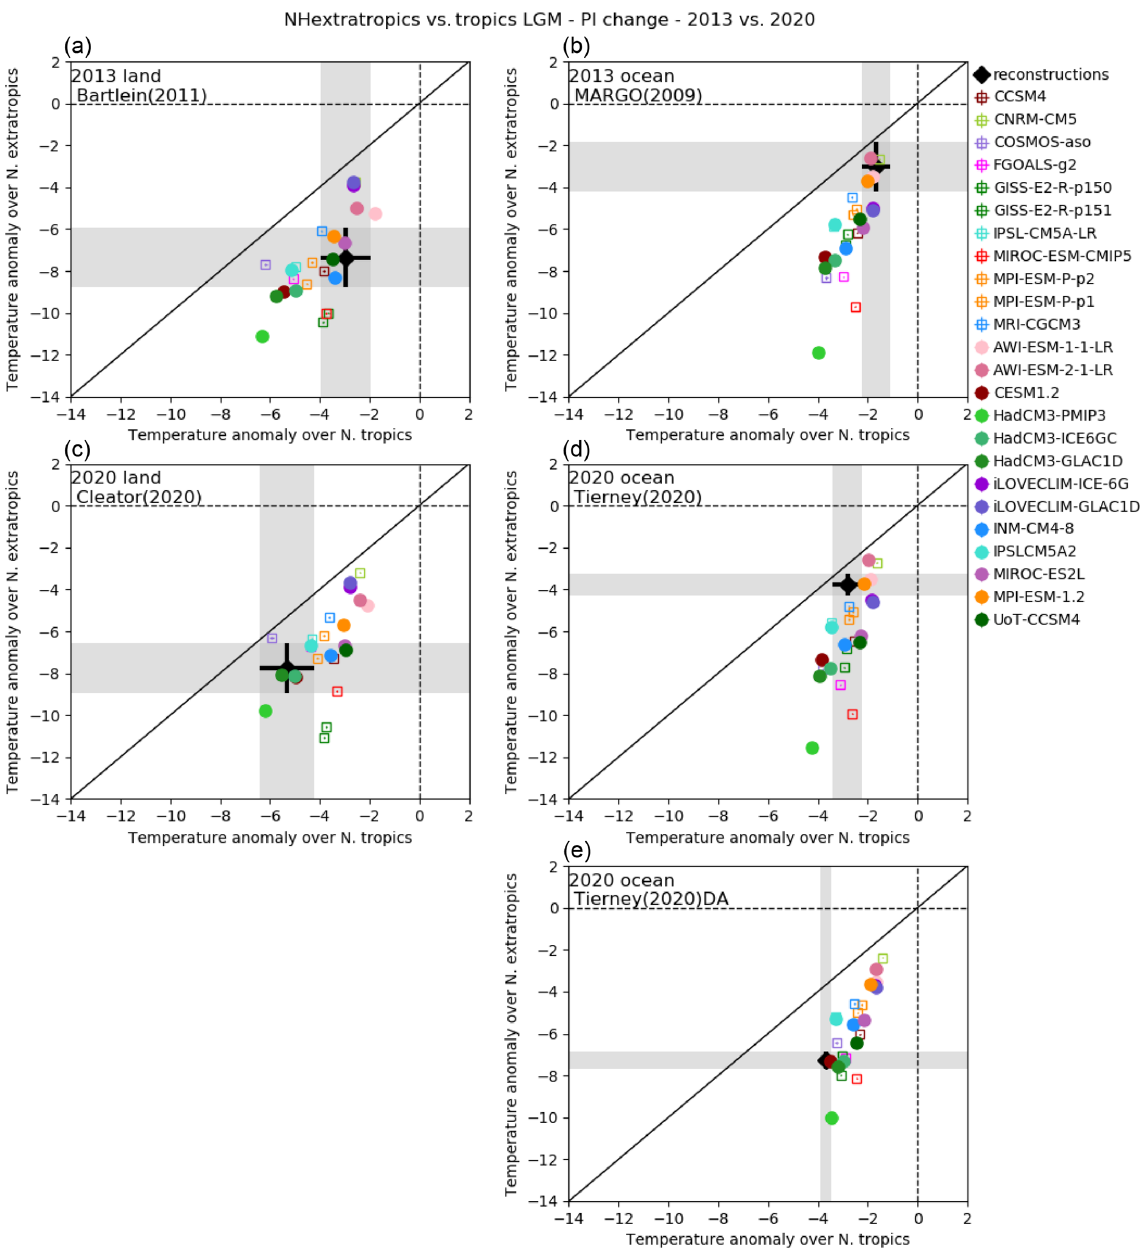
Figure 11. LGM–PI mean annual temperature anomaly over the northern extratropics (30–90 ◦ N) vs. over the northern tropics (0–30 ◦ N). The model output considered for the averages is taken only on grid points for which there are reconstructions. The four panels are based on the data syntheses of Bartlein et al. (2011) (a) , MARGO Project Members (2009) (b) , Cleator et al. (2020) (c) and Tierney et al. (2020) (d–e)